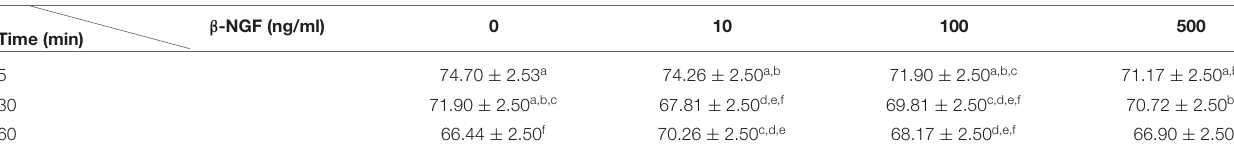
TABLE 2 | Percentage of llama sperm viability.